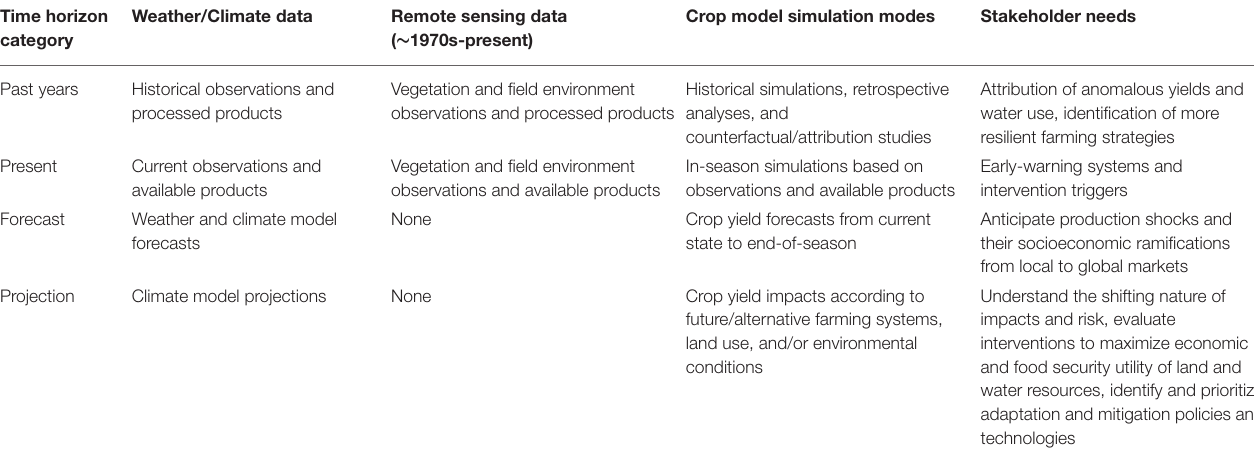
TABLE 1 | Observational and physical model sources of information to drive crop models across a continuum of stakeholder-relevant time